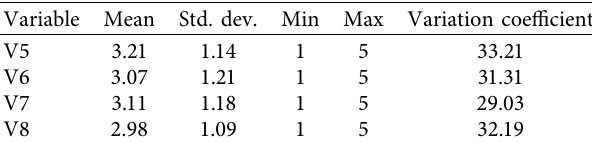
Table 3: Variation coefficient of learners’ knowledge and skills.